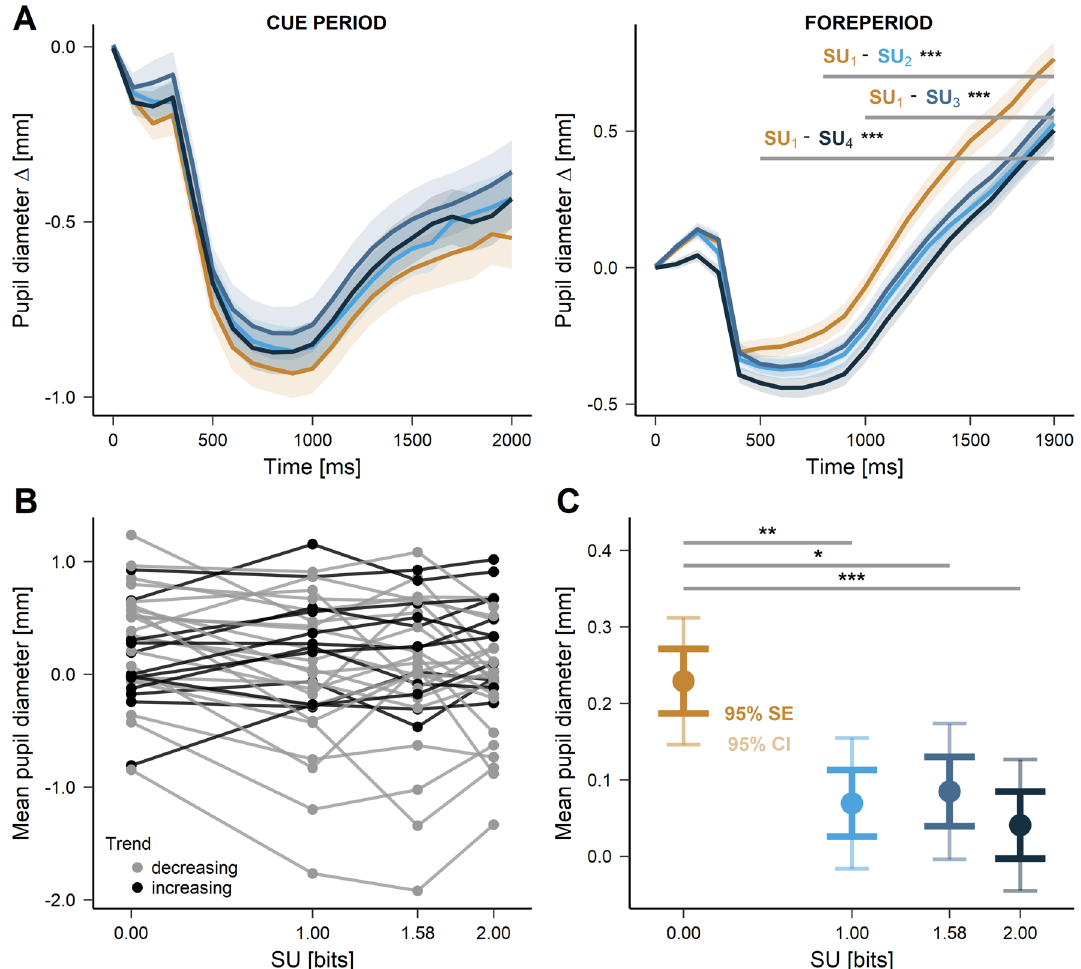
Figure 3. ( A ) Time course of pupil size during the cue period (left panel) and FP (right panel). Time ‘zero’ on the X-axis indicates the onset of the cue or the extinction of the warning stimulus. Colored lines indicate baseline corrected mean pupil size in the different SU conditions. Horizontal grey lines indicate clusters of differences between conditions, together with p-values obtained with the CBPT (* p (cid:31) .05, ** p (cid:31) .01, *** p (cid:31) .001). ( B ) Mean pupil size (dot) in each surprise condition in the 800–1900 ms FP interval for each subject. Black lines show individuals with an increasing trend, calculated as a difference between SU 1 and SU 4 conditions. ( C ) Mean pupil size (dot) for each SU context in the 800–1900 ms FP interval with standard errors and confidence intervals. Horizontal grey lines indicate LMM significance between